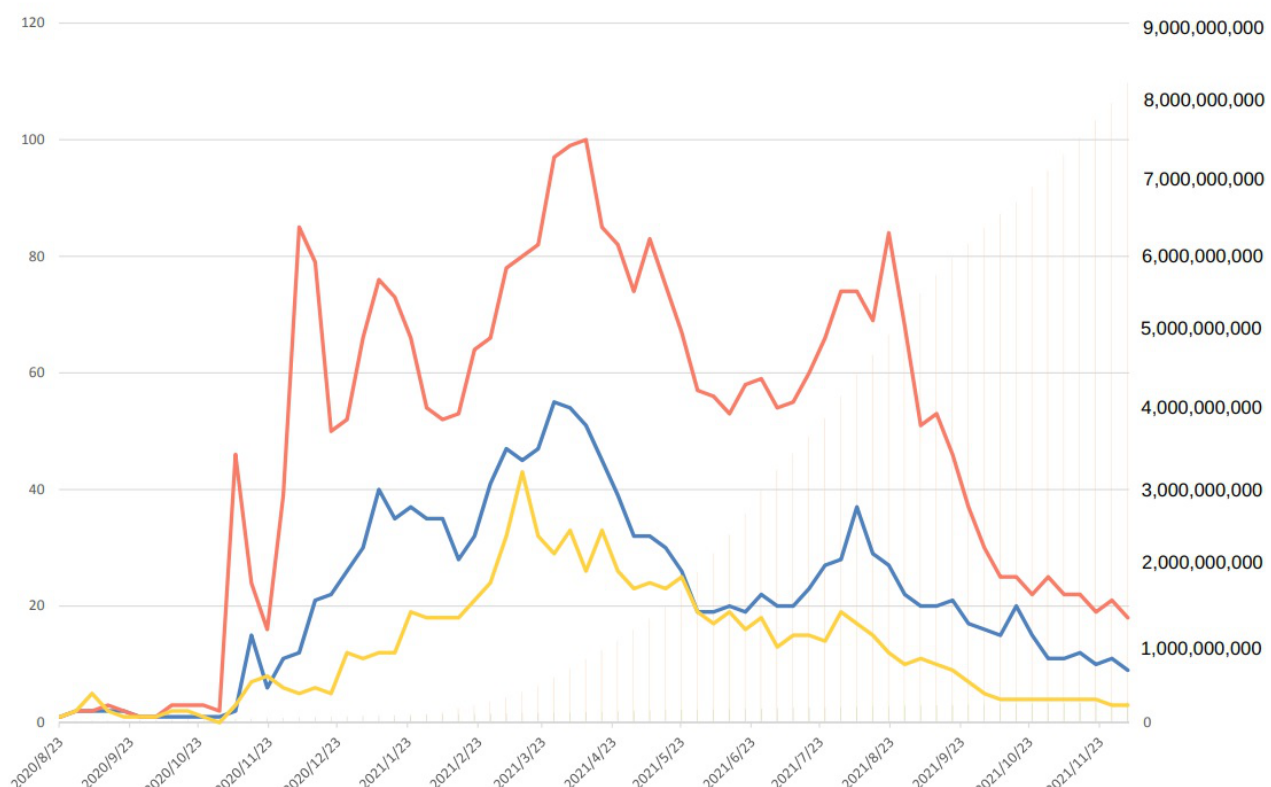
Figure 2. Display of Google Trend data for three major COVID-19 vaccines, including the Moderna vaccine, Pfizer/BNT vaccine, and AstraZeneca vaccine, as well as for total and new COVID-19 cases. Normalized search data were obtained from Google Trend (100—high interest; 0—no or insufficient interest data) for the period from 23 August 2020 to 5 December 2021. COVID-19 case data were